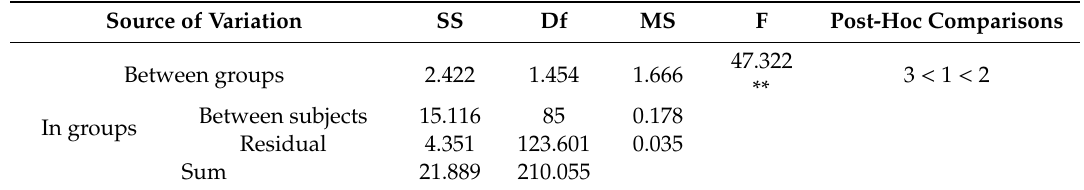
Table 1. Single-factor ANOVA results for Assessment 3 left eye visual acuity data. Source of Variation SS Df MS F Post-Hoc Comparisons Between groups